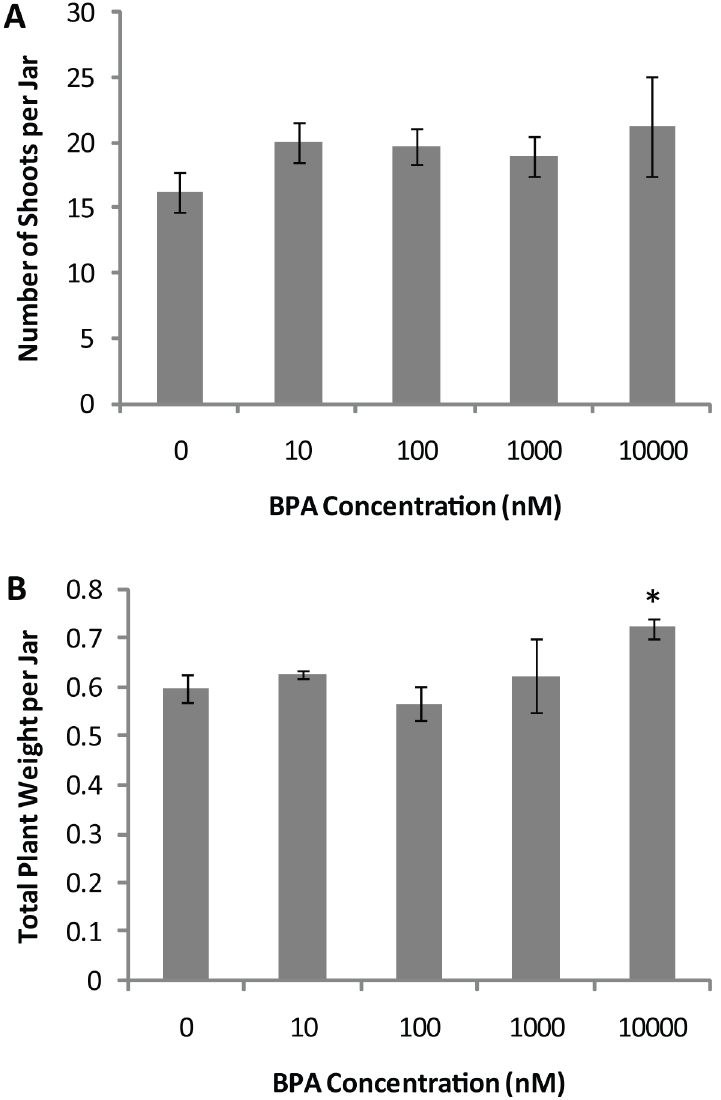
Fig 3. Effect of BPA on gross plant morphology. BPA had no significant effect on the number of shoots produced (A) and had a slight effect on total plant weight per jar (B). Bars represent the average of four jars of plants grown on agar containing BPA at each concentration. Error bars represent standard error. * indicates p-value < 0.05 when compared to 0nM BPA